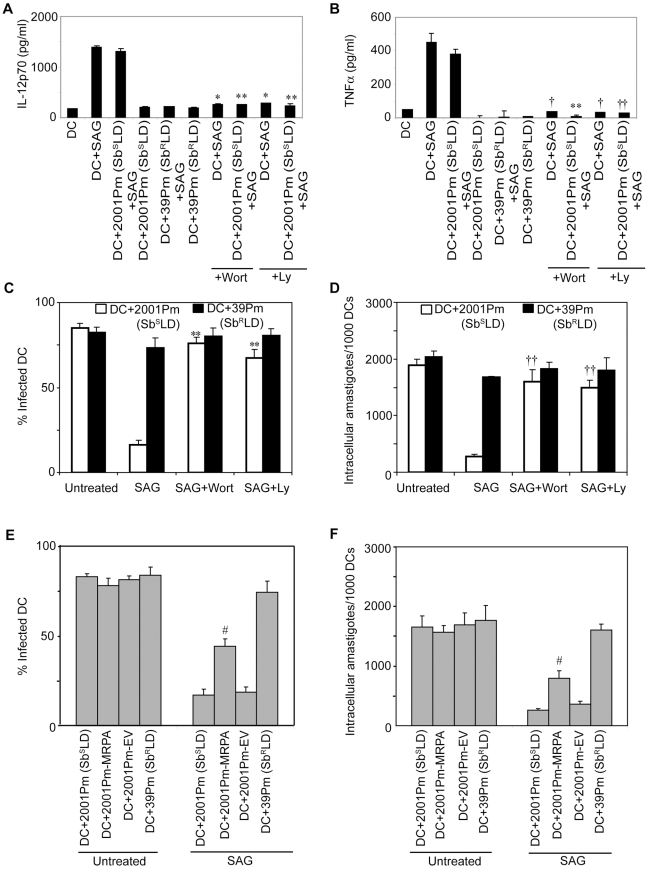
SbRLD inhibits SAG-induced proinflammatory cytokine production and leishmanicidal effects by suppressing PI3K/AKT pathway.BMDCs were infected for 3 hours with SbRLD strain 39Pm (A-F); SbSLD strain 2001Pm (A-F); 2001Pm expressing MRPA (2001Pm-MRPA) (E-F); or 2001Pm transfected with empty vector (2001Pm-EV) (E-F) or left uninfected as described in Figure 4. BMDCs were washed and then stimulated with SAG (20 µg/ml) for 48 (A-B) or 24 (C-F) hours. For experiments (A-D); uninfected BMDCs (A-B), and BMDCs infected with 2001Pm (SbSLD) (A-D) or 39Pm (SbRLD) (C-D) were treated with 200 nM Wort or 50 µM Ly for 1 hour prior to SAG treatment. (A-B) Secretion of IL-12 (A) and TNFα (B) were determined by ELISA. (C-F) Giemsa staining was performed to determine the percentage of infected BMDCs (C, E) and number of intracellular amastigotes per 1000 BMDCs (D, F). Data are representative of three independent experiments. *p<0.001 and †p<0.005 versus DC+SAG; **p<0.001 and ††p<0.005 versus DC+2001Pm+SAG; #p<0.04 versus DC+2001Pm (SbSLD) or DC+2001Pm-EV (Student's t test). Error bars indicate mean ± SD.